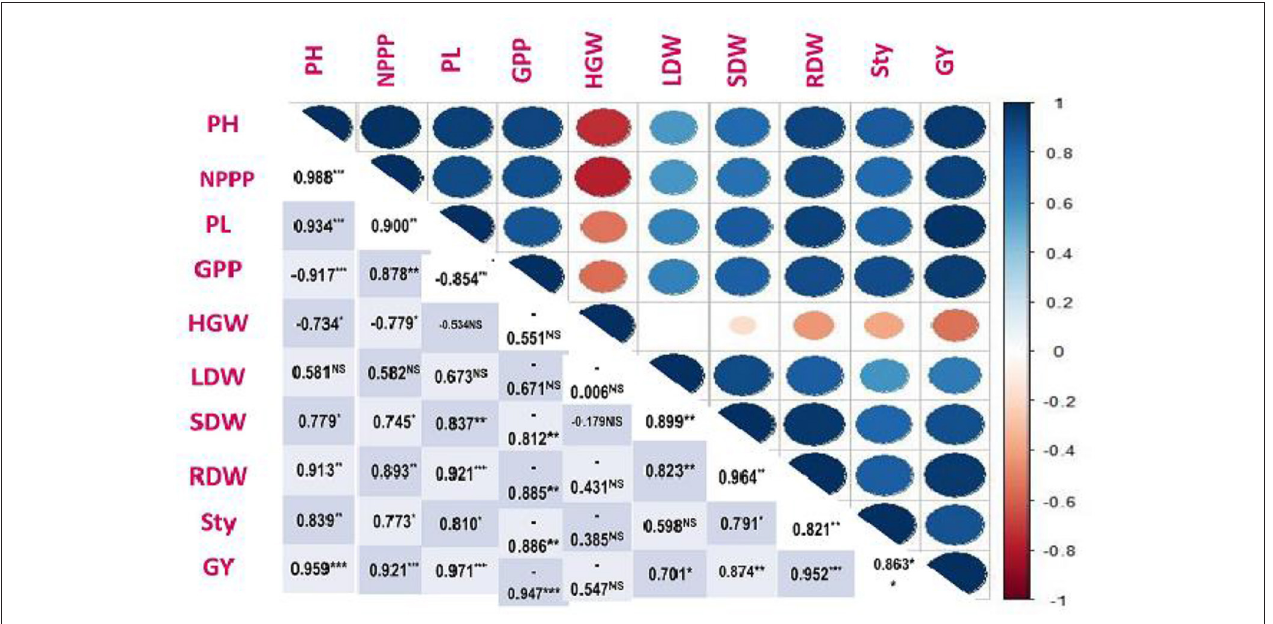
FIGURE 3 | Correlation coefficients of grain yield on growth traits and yield components in V. radiata . According to the color scale, the darker positive scale represents most of the treatment responses, while the darker negative stripes show the least response. The dark blue color showed a high positive association and the dark red color showed a high negative correlation between traits. Similarly, as the color intensity decreases, the treatments show moderate performance in both the positive and negative ranges (PH, Plant height; NPPP, Number of pods per plant; PL, Pod length; GPP, Grains per pod; HGW, Hundred grain weight; LDW, Leaf dry